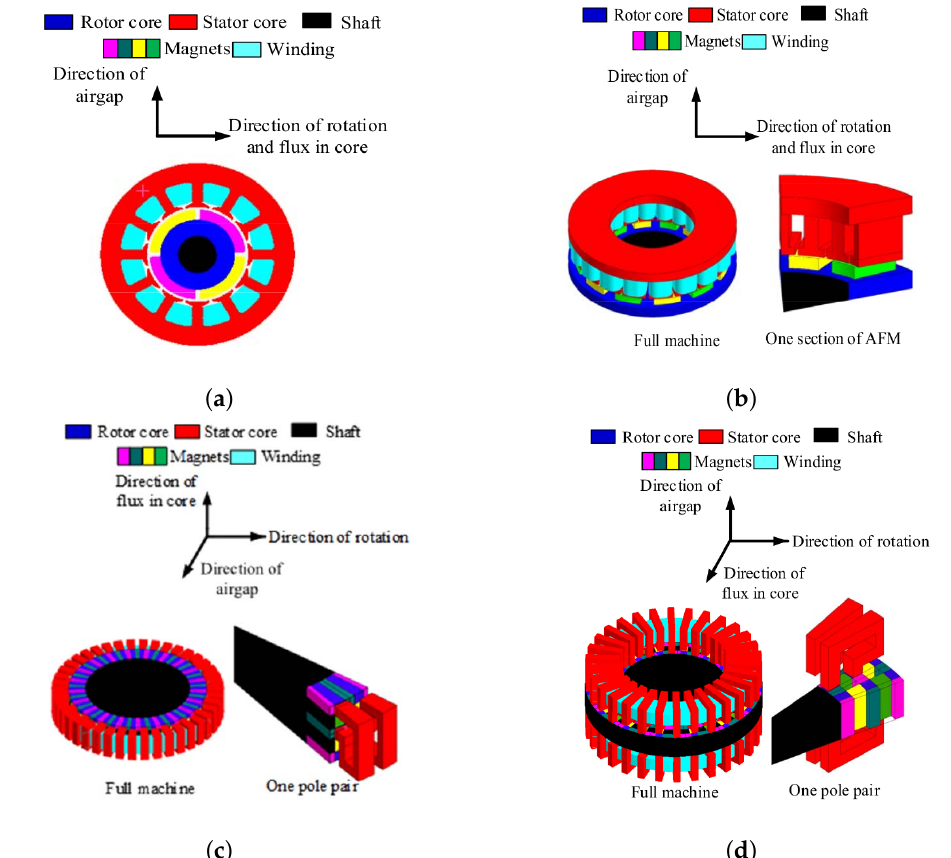
Figure 1. ( a ) RFM, ( b ) AFM, ( c ) TFM with radial air gap, ( d ) TFM with axial air gap